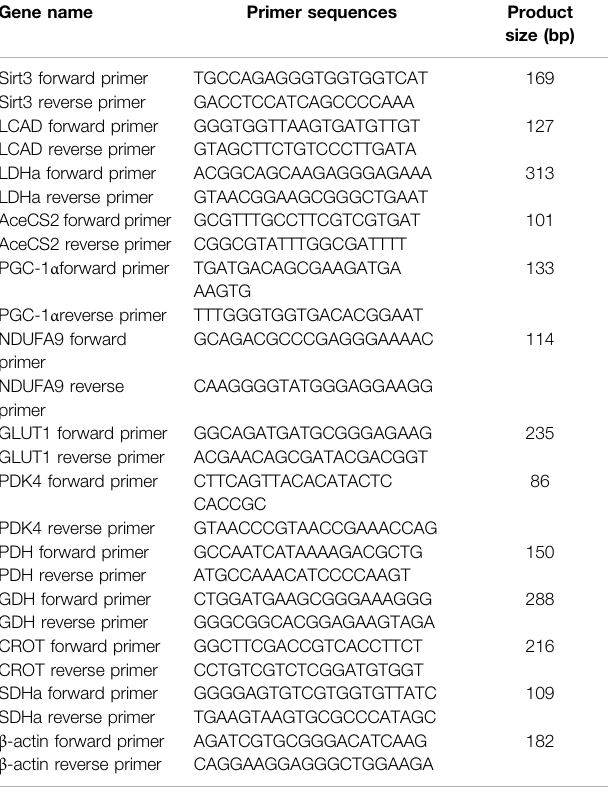
TABLE 2 | Primers for real-time